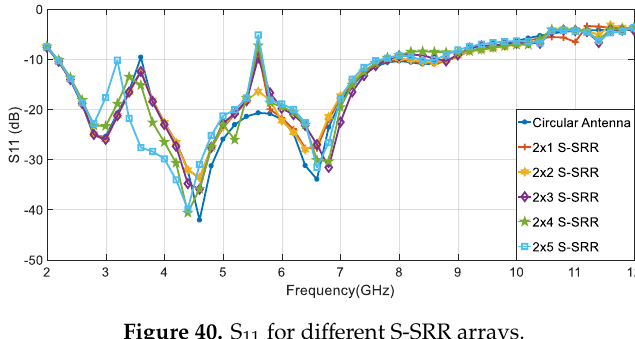
Figure 40. S 11 for different S-SRR arrays. Table 5. Results of S-SRR arrays implementations with the antenna.